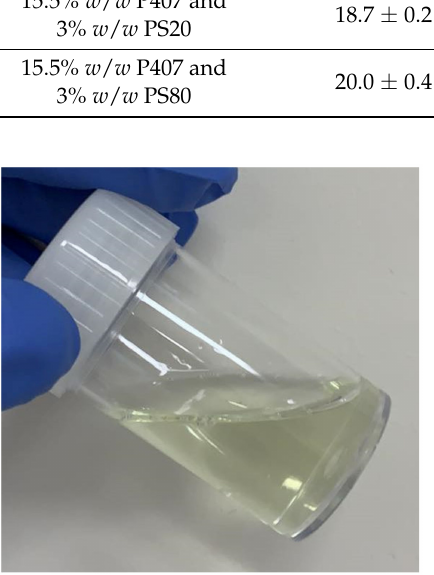
Figure 1. Binary PS20/P407 mixed micelles.